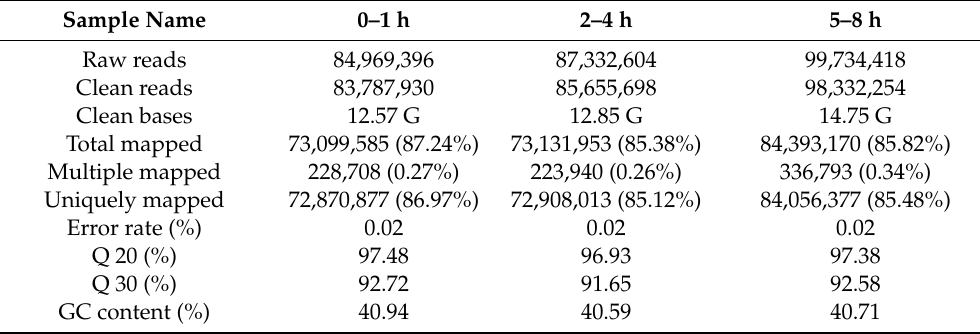
Table 2. Alignment statistics of the B. dorsalis early embryo RNA-Seq